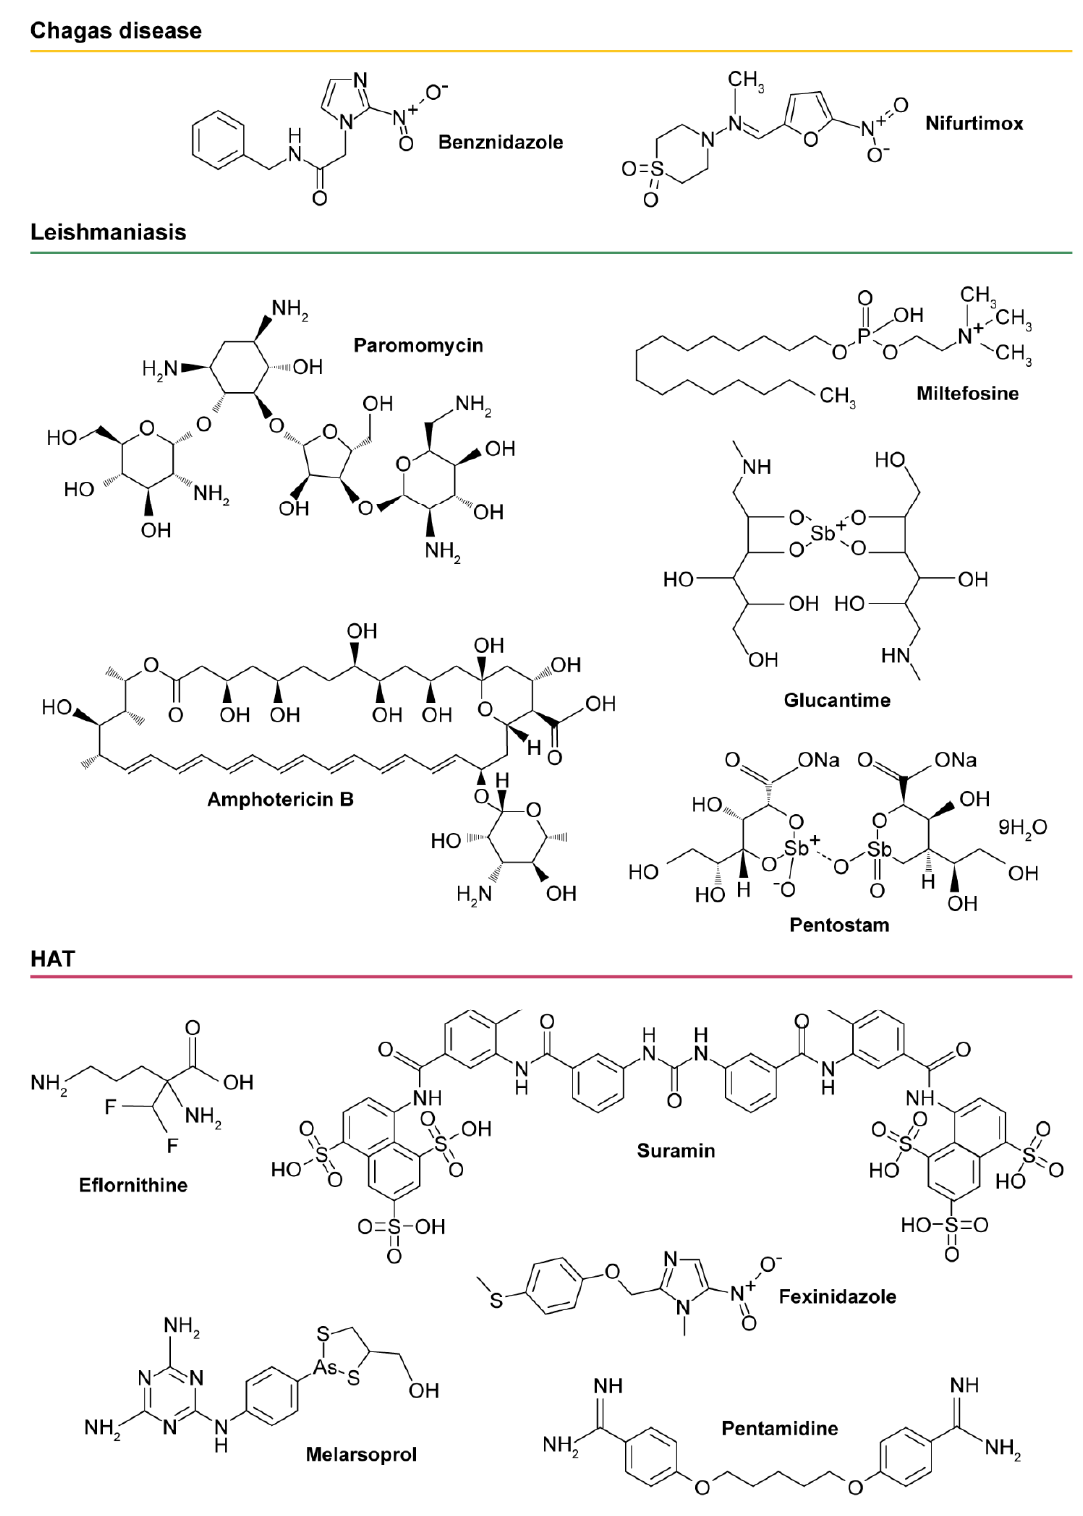
Figure 1. Drugs in clinical use against Chagas disease, leishmaniasis, and human African trypanosomiasis (HAT).